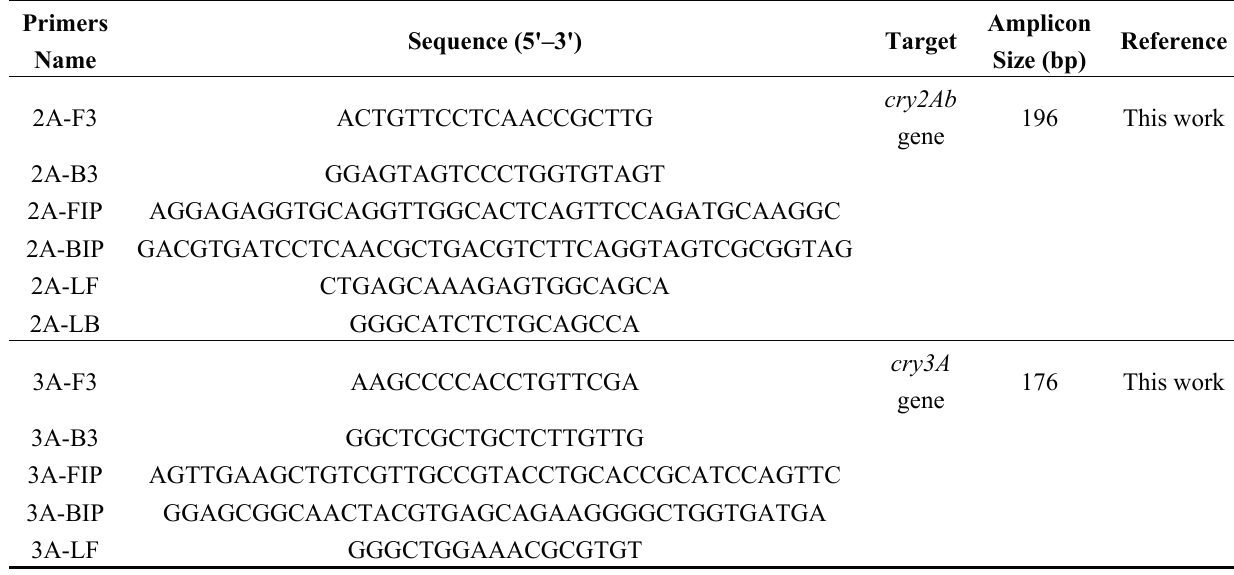
Table 1. Oligonucleotide primers used in this study.